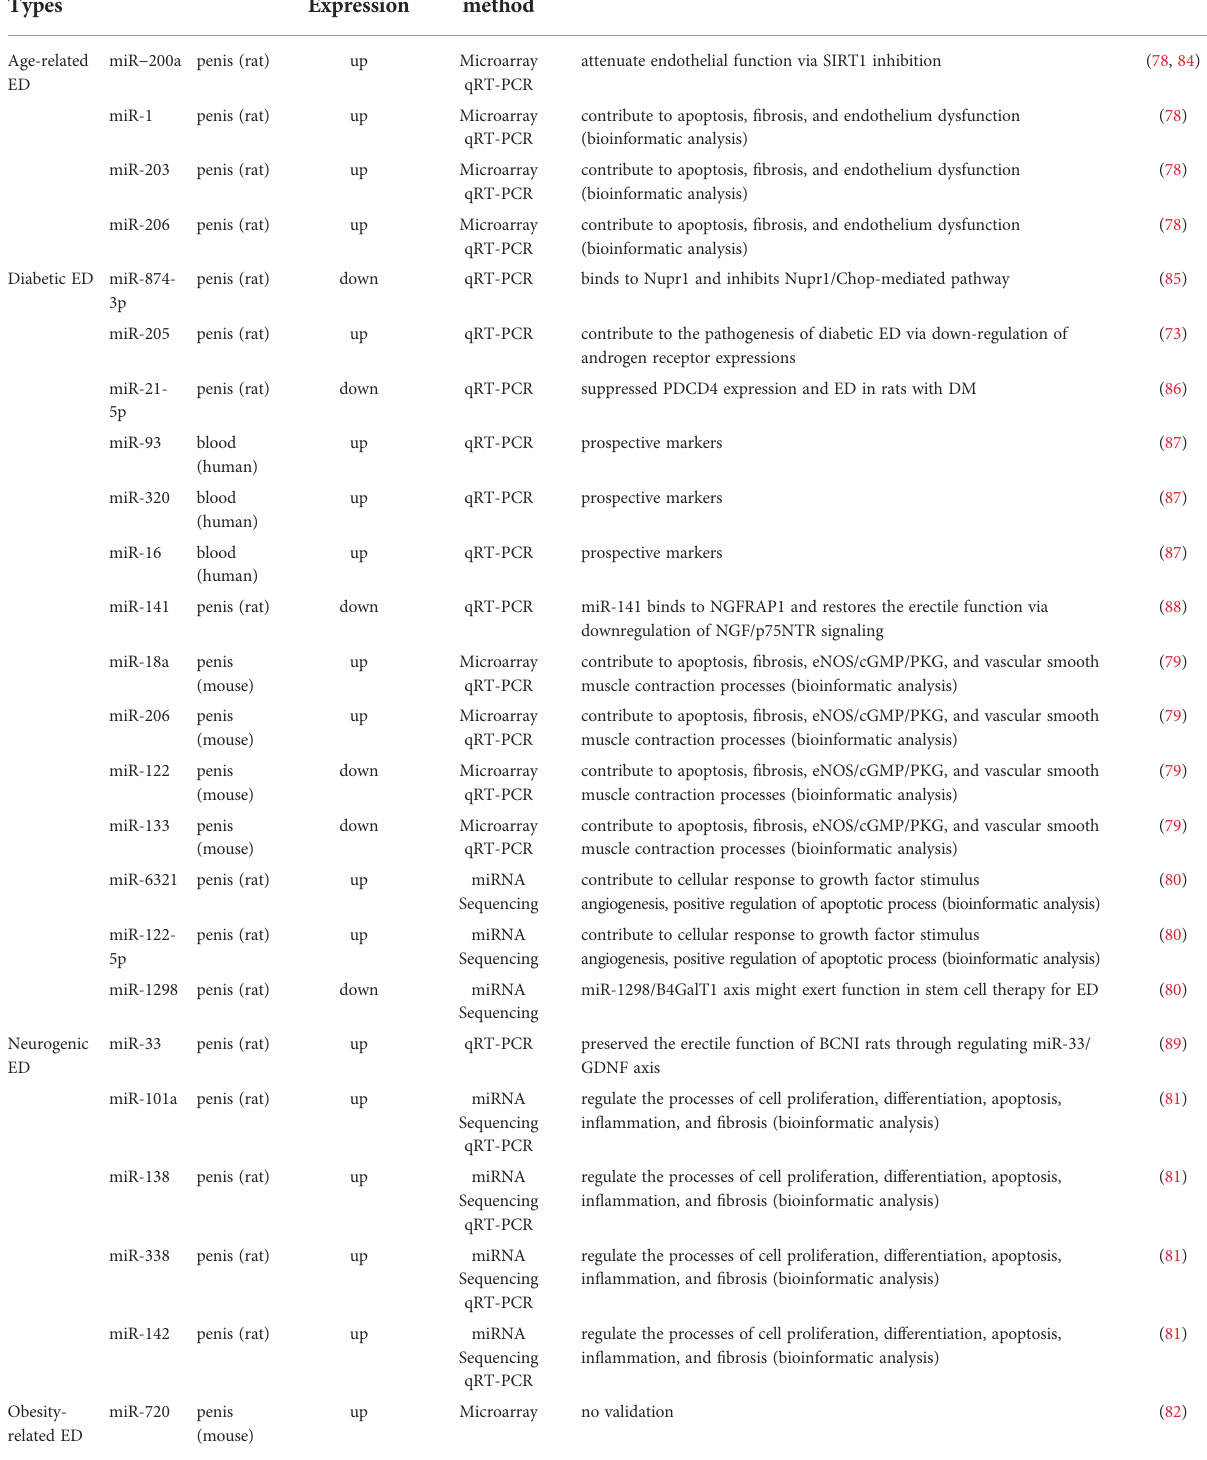
TABLE 2 The expression and function of differentially expressed miRNAs in various